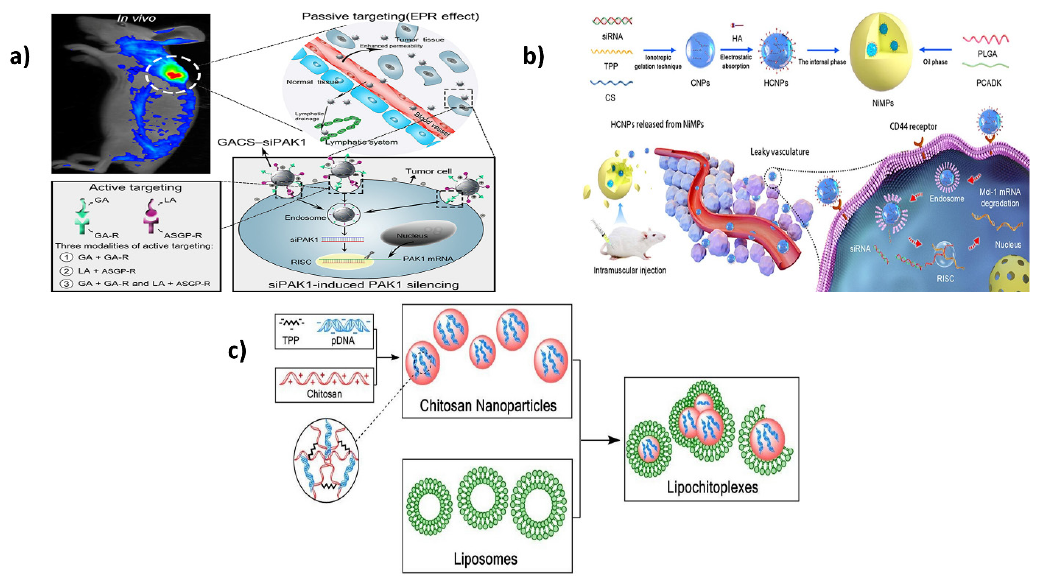
Figure 2. ( a ) Delivery of siRNA via Dual-Targeting Nanoparticle-based Gene Therapy for Hepato- cellular Carcinoma [128]; ( b ) A systematic approach for rheumatoid arthritis treatment using PLGA/PCADK hybrid microspheres encapsulating hyaluronic acid–chitosan siRNA nanoparticles. Reproduced with permission from [129], copyright Elsevier 2021; ( c ) Improved gene delivery with lipid-enveloped chitosan-DNA nanoparticles. Reproduced with permission from [130], copyright Elsevier